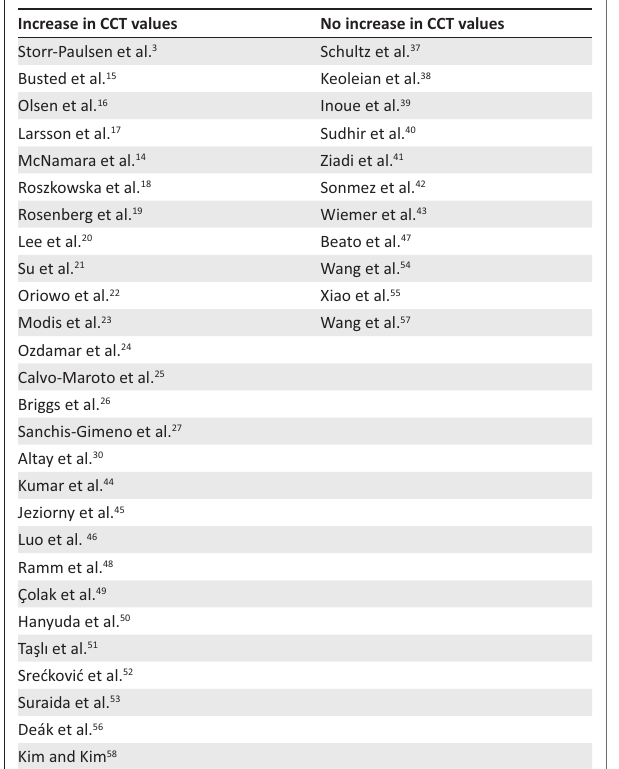
CCT, central corneal thickness. FIGURE 1: Comparative table showing studies that detected an increase in central corneal thickness values in diabetes mellitus versus those that did not.